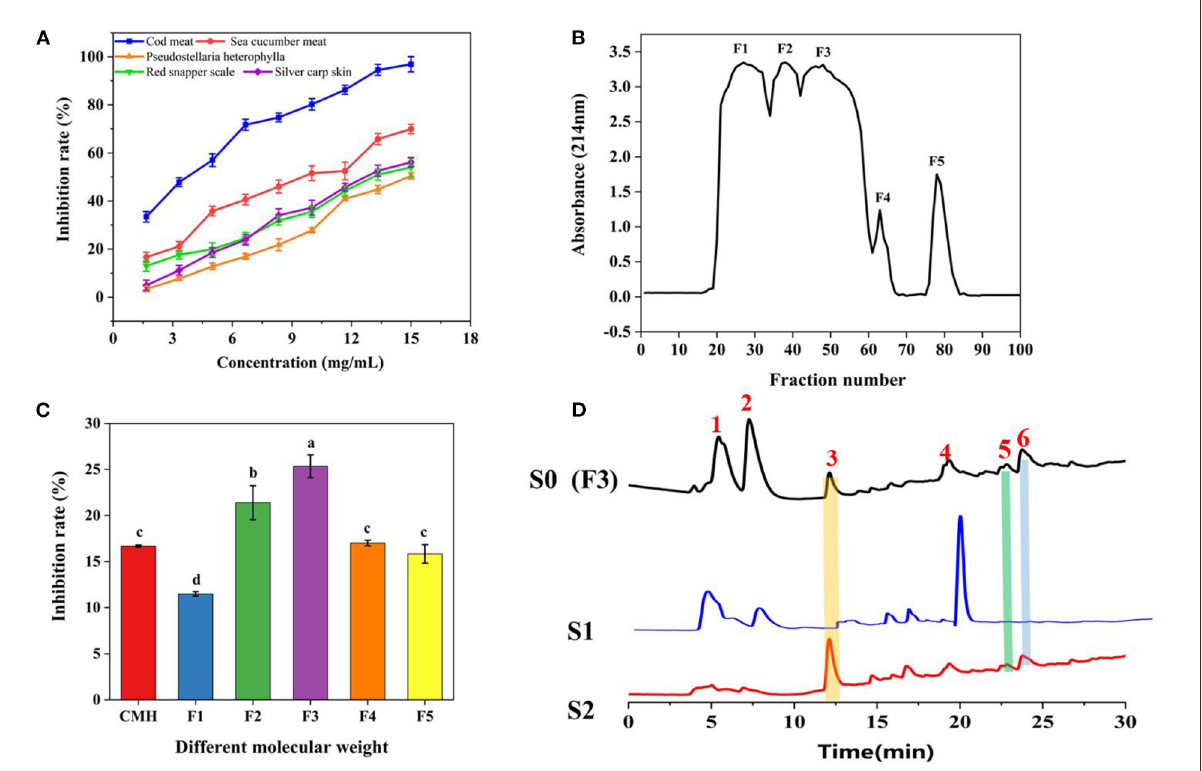
FIGURE2 The process of fishing out PLIs from protein hydrolysates. (A) Screening of the most active protein hydrolysate. (B) Separation of CMH with a gel column G-15. (C) Screening of active fractions at a concentration of 1 mg/mL. (D) HPLC comparison of active components (F3/S0), non-specific ligands (S1) and specific ligands (S2). The superscript letters indicate significance analysis. The same letters mean no